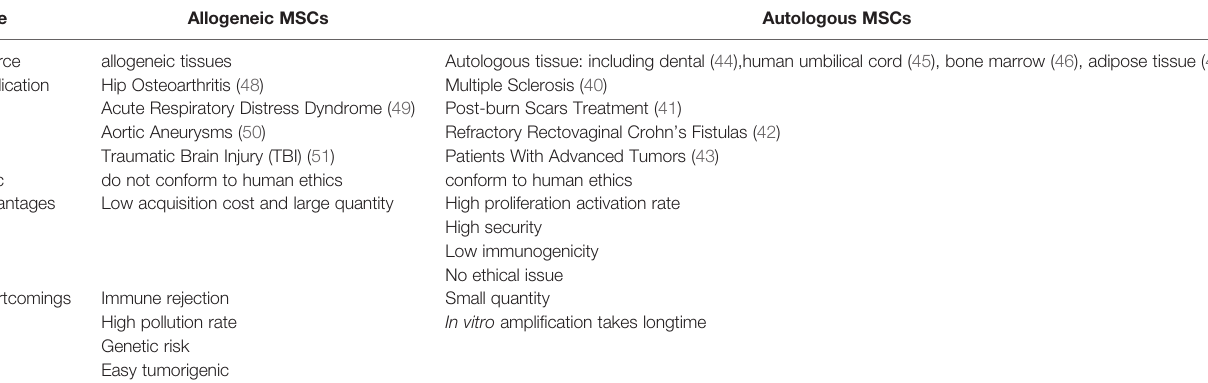
TABLE 2 | This table mainly compares the differences between autologous MSCs and allogeneic MSCs from fi ve aspects: source, application, ethics, advantages and